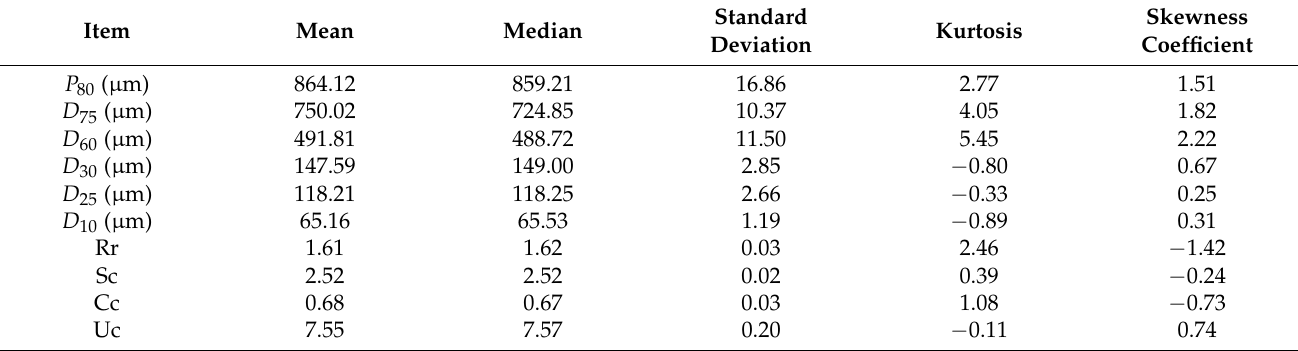
Table A11. Descriptive statistics for ore a under 4 min grinding for descriptive parameters of